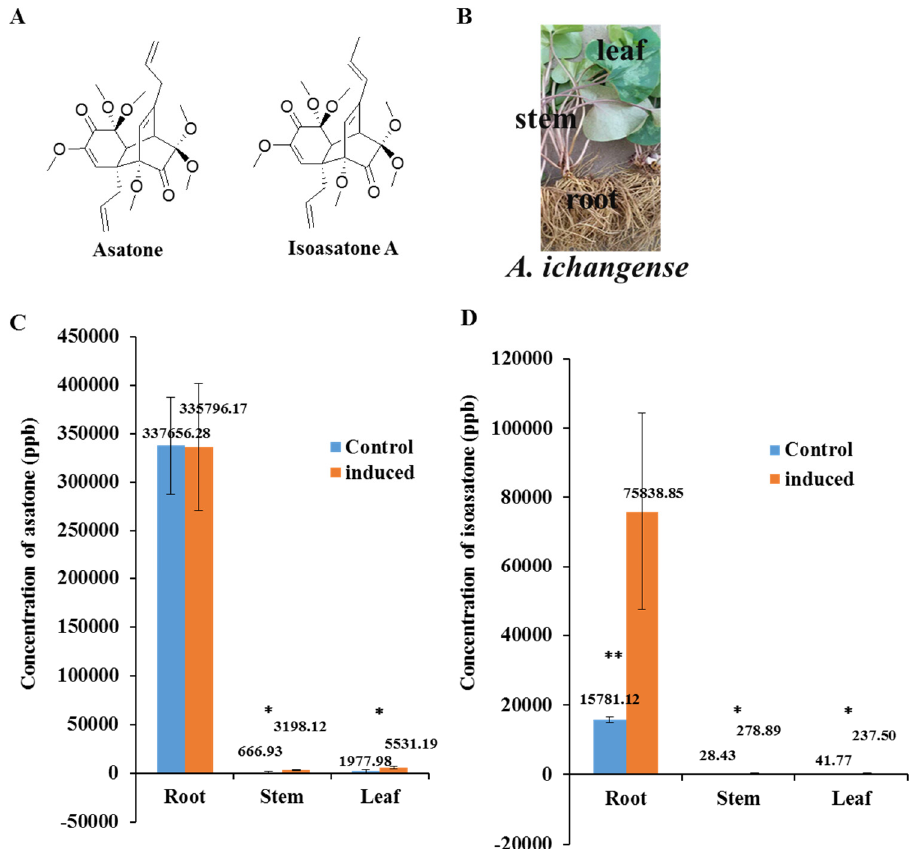
Figure 1. The compounds asatone and isoasatone a distribution in Asarum ichangense . ( A ) Chemical structures asatone and isoasatone from A. ichangense . ( B ) Photos showing A. ichangense . ( C ) Concentration of asatone with (induced) and without (control) S. litura feeding on roots, stems, or leaves. ( D ) Concentration of isoasatone a with (induced) and without (control) S. litura feeding. ( e. mean +/ − s.e.; n = 3; * p < 0.05, t -test.